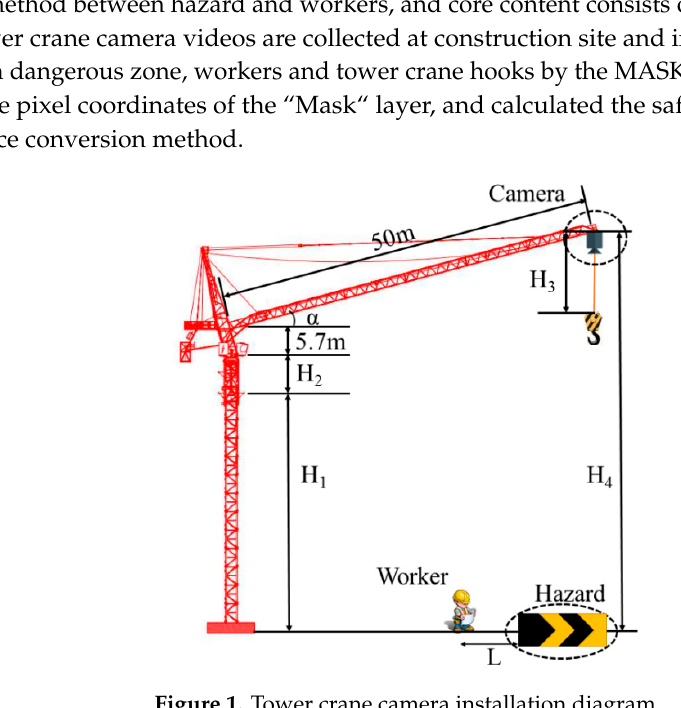
Figure 1. Tower crane camera installation diagram.